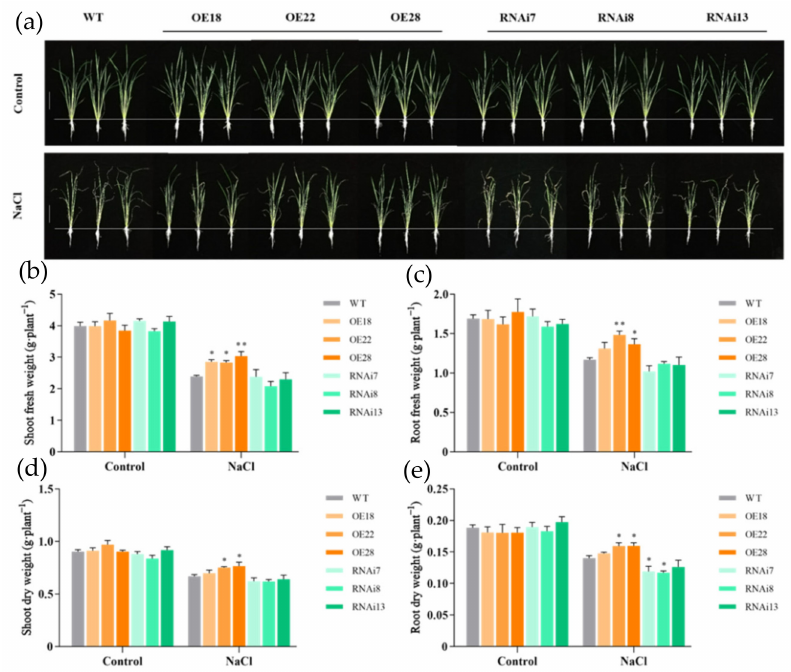
Figure 1. Effects of NaCl treatment on growth of the wild-type line (WT), overexpression lines (OE18, OE22, and OE28), and RNAi lines (RNAi7, RNAi8, and RNAi13). Rice seedlings grown for 25 days were treated with 0 or 100 mM NaCl for 6 days. ( a ) Photos were taken on the sixth day after NaCl treatment; ( b ) shoot fresh weight, ( c ) root fresh weight, ( d ) shoot dry weight, and ( e ) root dry weight were measured after NaCl treatment. The experiment was repeated three times, and each treatment included four replications. Data are means ± SE ( n = 5). An asterisk indicates a significant difference (LSD test, * p < 0.05 and ** p < 0.01) between wild-type, overexpression, and RNAi